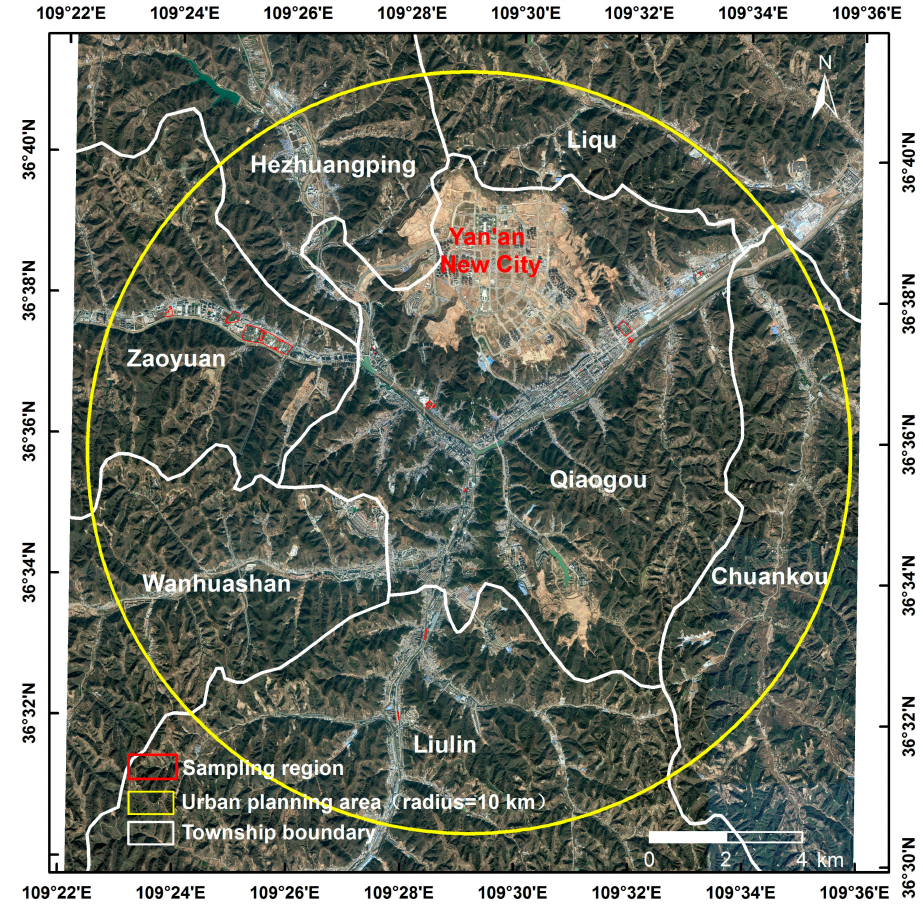
Figure 2. Map showing the distribution of sampling points in the region (plots).